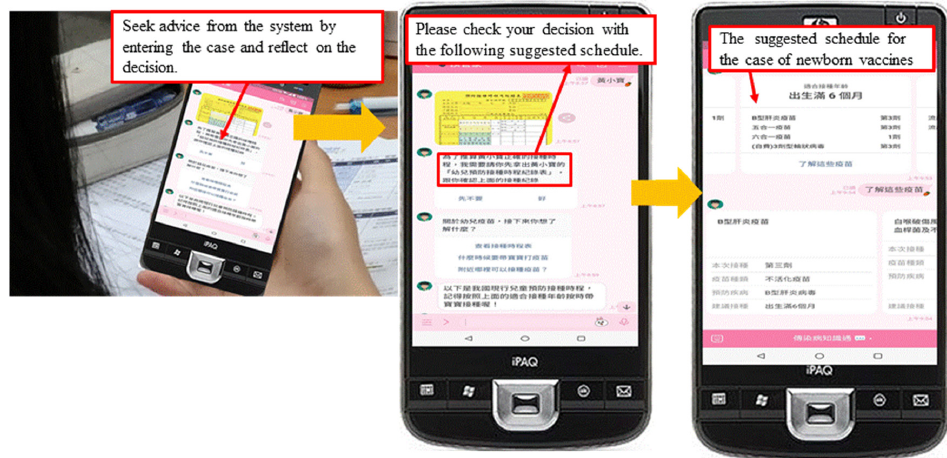
Figure 3. Example of the Reflection stage.